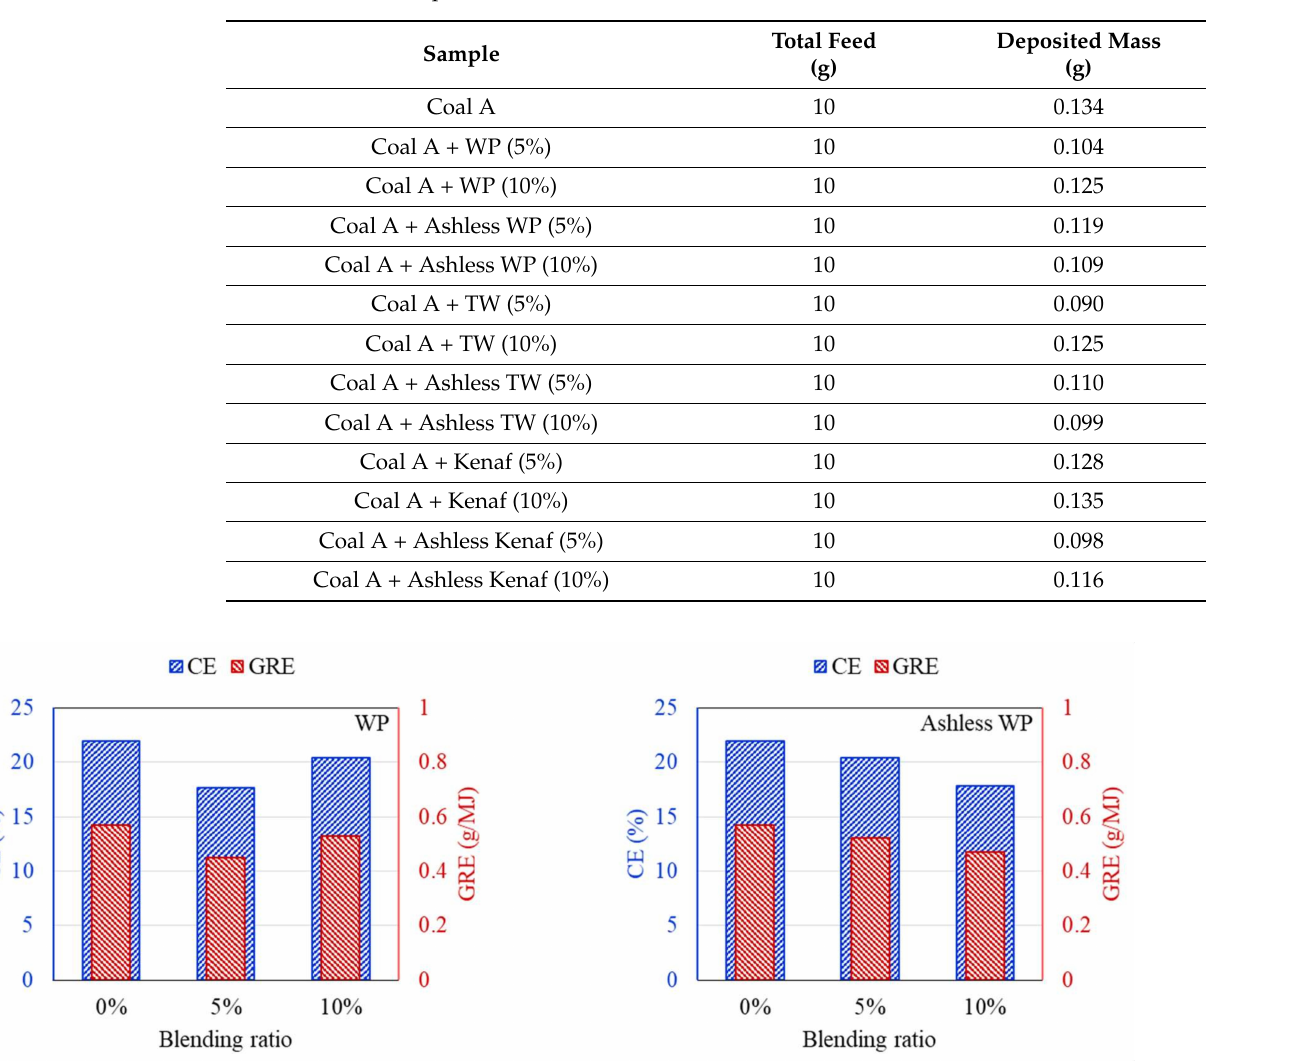
Table 4. Feed and deposited ash mass for coal and coal mixtures.